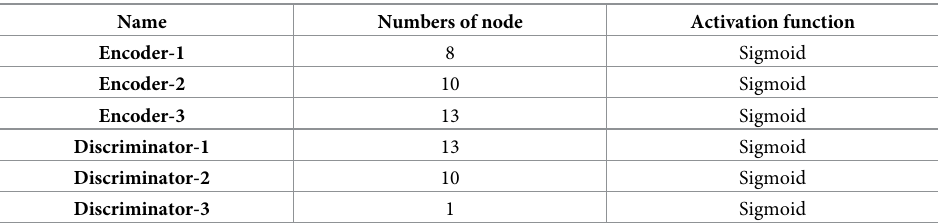
Table 2. Parameters of the GAN